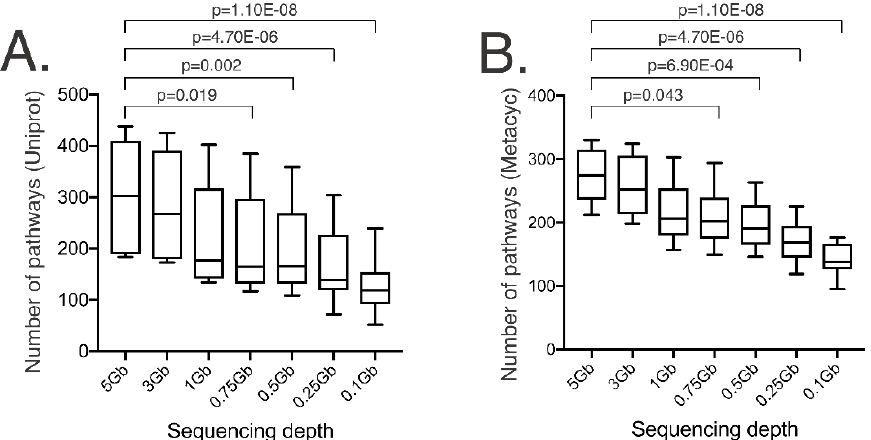
Figure 6. Boxplots of the total number of functional pathways identified in ten stool samples across various sequencing depths including 5 Gb (16.67 M reads), 3 Gb (10.00 M reads), 1 Gb (3.00 M reads), 0.75 Gb (2.50 M reads), 0.5 Gb (1.65 M reads), 0.25 Gb (0.85 M reads), and 0.1 Gb (0.34 M reads). ( A ) Number of UniProt pathways across the various sequencing depths. ( B ) Number of MetaCyc pathways across the various sequencing depths.